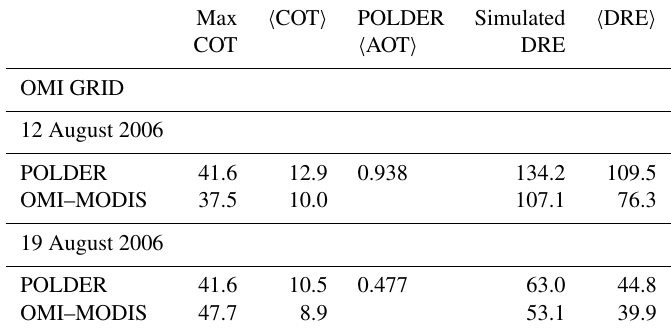
Table 4. Average values of the OMI–MODIS COT and the POLDER COT and above-cloud AOT on 12 and 19 August 2006 in 20–0 ◦ S, 8 ◦ W–14 ◦ E. The DRE was calculated using the average AOT from POLDER and the average COT values for both OMI–MODIS and POLDER, assuming a CER of 8µm, an aerosol SSA of 0.840 at 550nm and an aerosol geometric radius of 0.1µm. The angled brackets denote the averaged values described in the text. Max (cid:104) COT (cid:105) POLDER Simulated (cid:104) DRE (cid:105) COT (cid:104) AOT (cid:105)